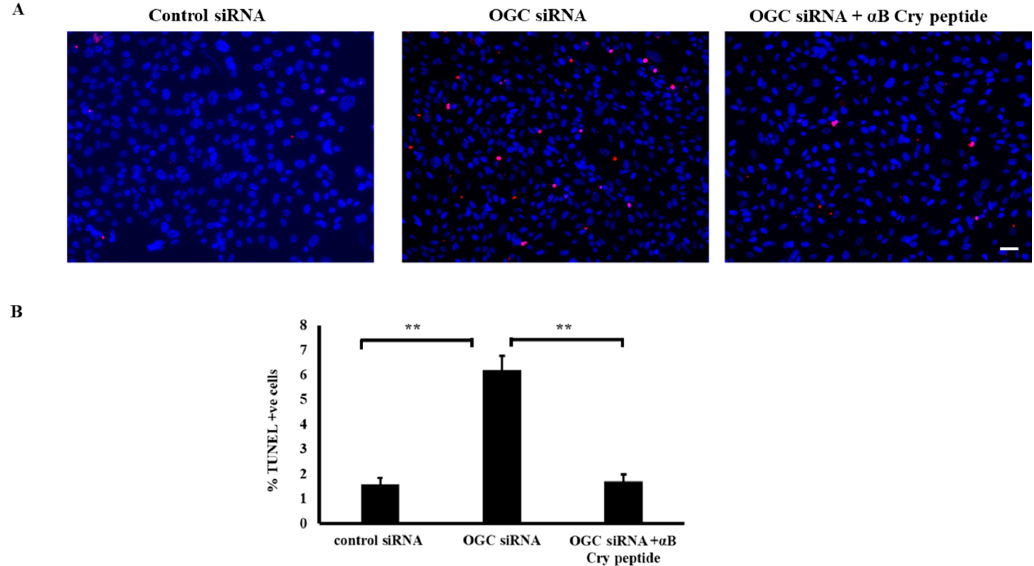
Figure 2. siRNA mediated knockdown of OGC augmented RPE cell death and α B cry peptide treatment increased cell survival. ( A ) Primary cultured RPE cells were transfected with OGC siRNA or control siRNA and 24 h post-transfected cells were treated with α B cry peptide (75 µg/mL) for an additional 24 h. Cell death was measured by TUNEL assay. The number of apoptotic cells increased 4-fold in OGC silenced RPE compared to control siRNA transfected group. ( B ) A significant reduction in apoptotic cells in α B cry peptide treated groups vs. inhibitor-treated groups was observed. n = 4; ** p < 0.01; Scale bar: 50 µm.